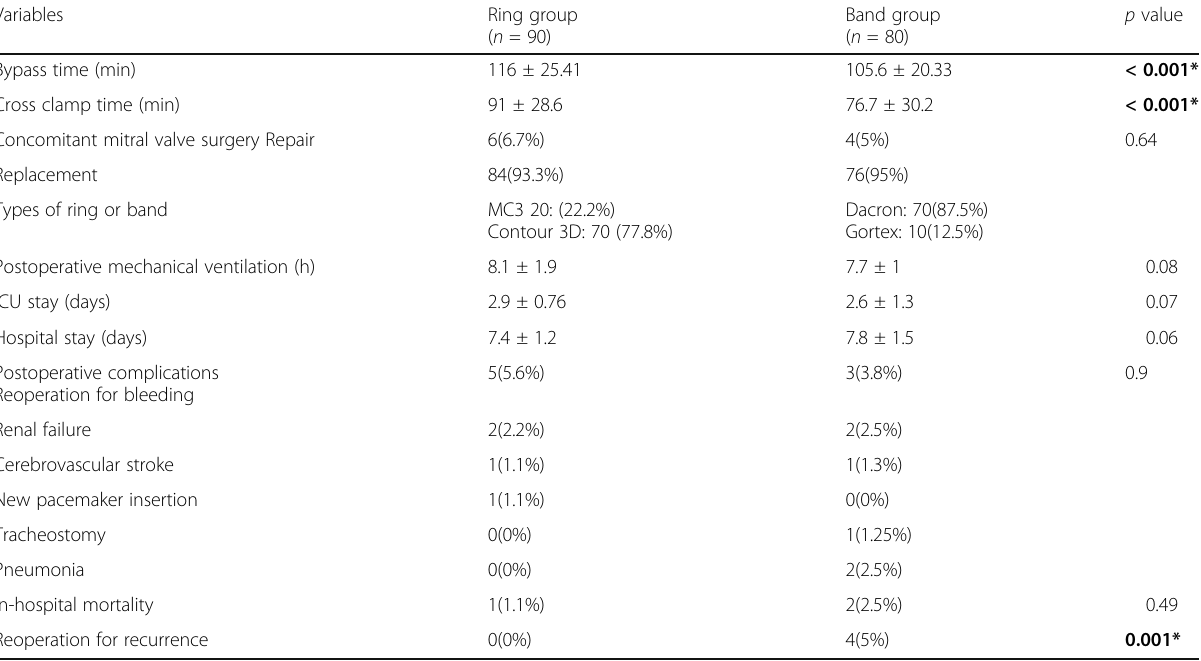
Table 2 Operative and outcome data in both study groups